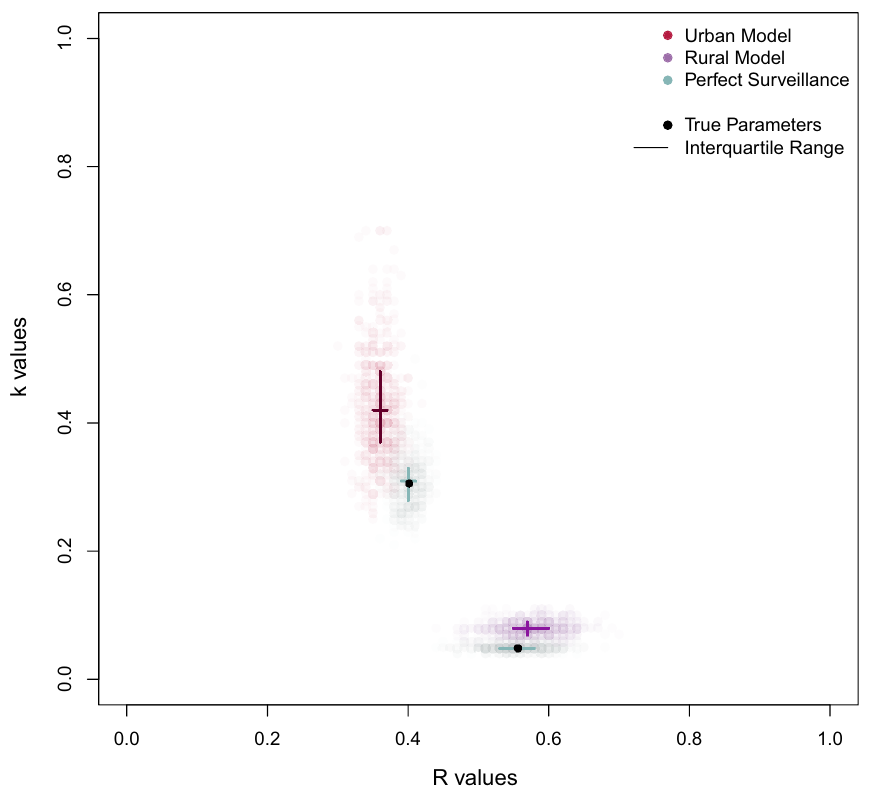
Figure 6. Sensitivity of model inference to imperfect surveillance. We simulated 500 perfect and imperfect TB surveillance systems for both the urban and rural models, each with 2000 chains of transmission. True underlying R and k values were specified by the inferred values from the respective populations. In perfect surveillance, all cases were observed with no censoring or sub-clustering. Imperfect simulations combined the following assumptions: only 40% of cases were observed ( p 1 = 0.40 ) and only 15% of otherwise missing cases were identified by active case finding ( p 2 = 0.15 ) for both models. The proportion of censored clusters ( p cens ) and genotypic clusters containing multiple sub-clusters ( p over ) were consistent with the observed values ( p cens = 0.07 and 0.07 and p over = 0.15 and 0.28 for the urban and rural models, respectively). See supplemental materials for detailed methods and results from the simulation